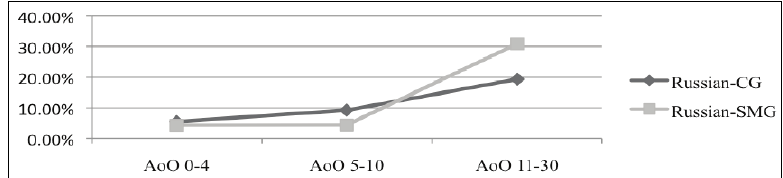
Figure 4: AoO of the participants and non-target test production